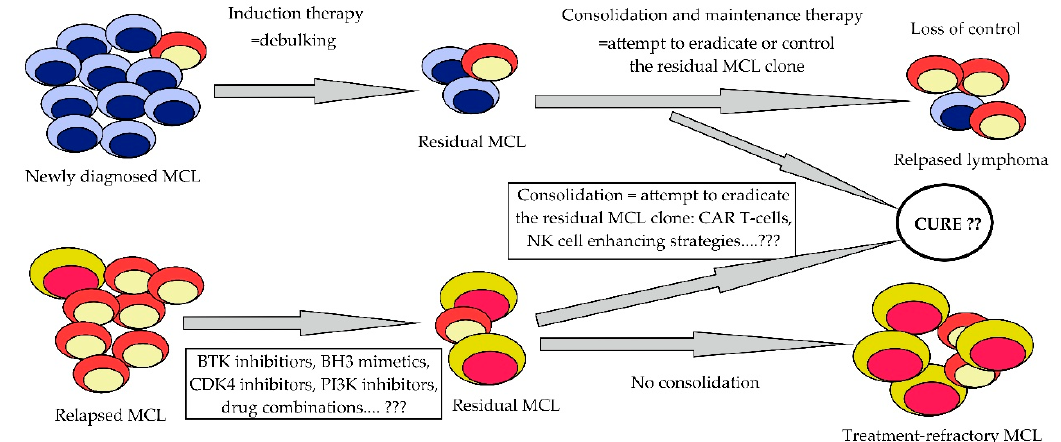
Figure 4. Current and future treatment algorithms in front-line and salvage therapy of MCL.